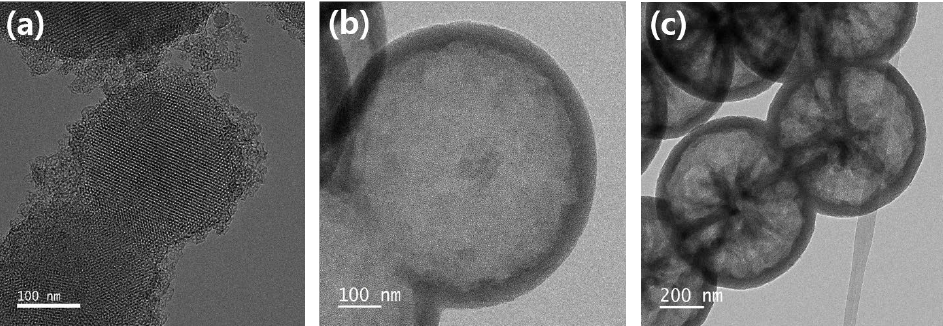
Figure 2. TEM images of mesoporous silica and mesoporous hollow silica: ( a ) MS-C, ( b ) MHS-C, and ( c ) MHS-R.